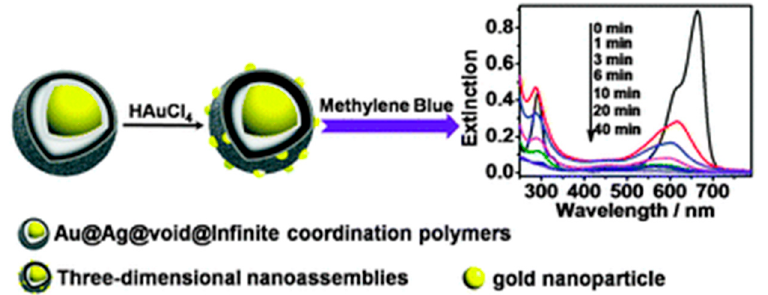
Figure 29. Three-dimensional assembly of gold nanoparticles on Au@Ag@void@infinite coordina- tion polymers with oxidase-like activity for the degradation of methylene blue. (Reprinted with permission from [205]. Copyright © 2014, Royal Society of